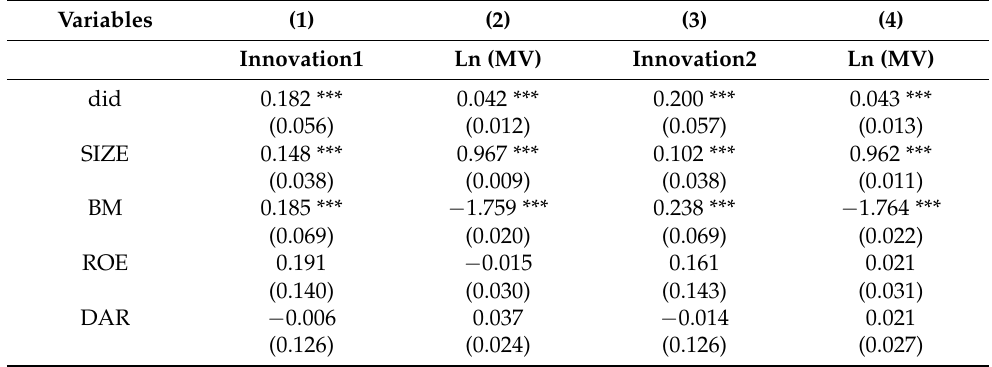
Table 7. Regression results of mediation mechanism analysis based on technological